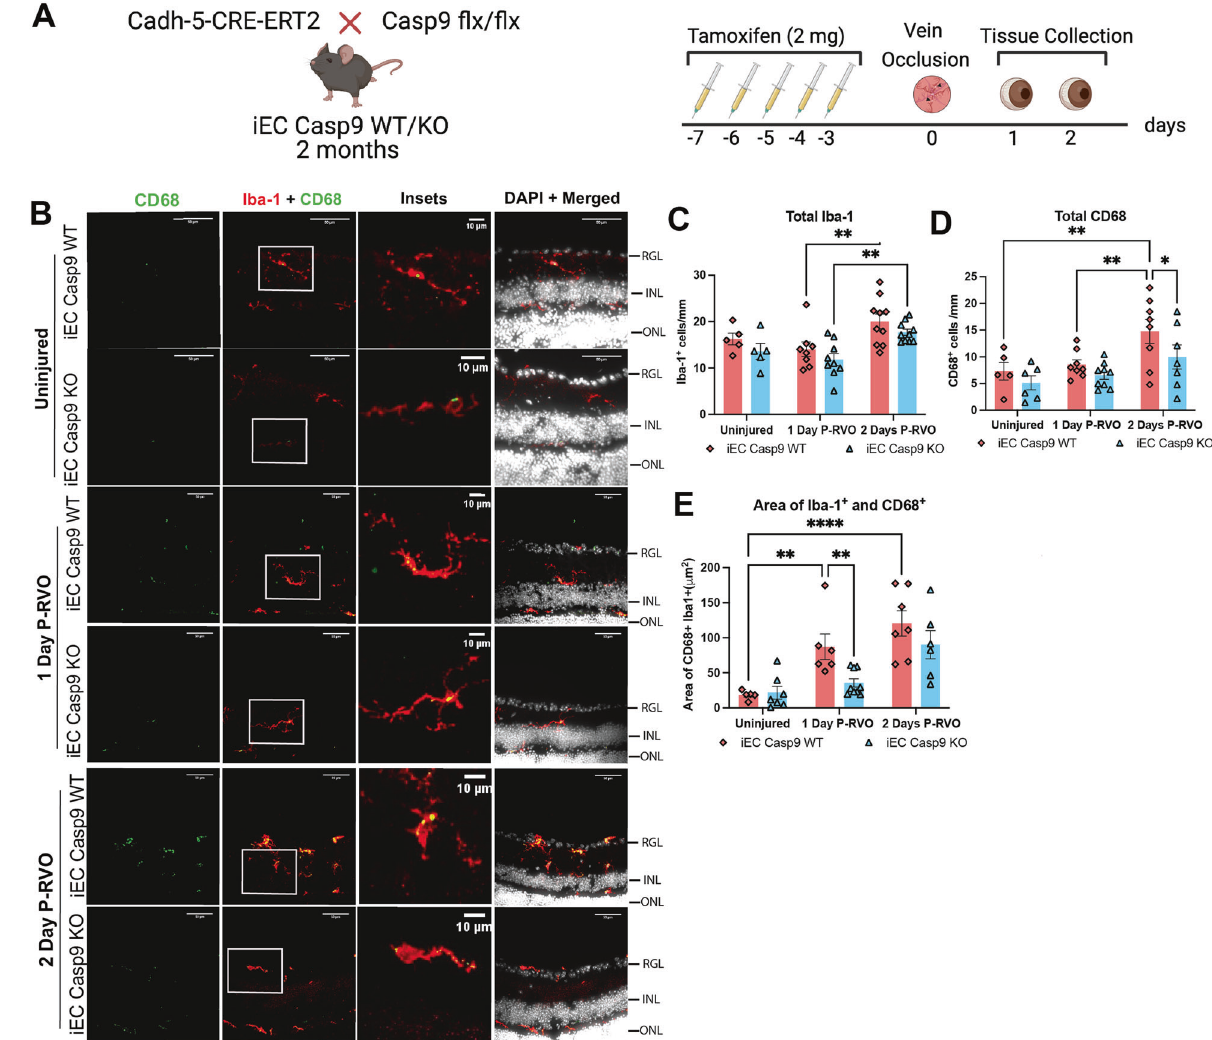
P-RVO. Created with BioRender.com. B Retinal cross-sections from uninjured, one and two days P-RVO iEC Casp9 WT and KO mice were stained with CD68 (green), Iba-1 (red), and DAPI (white). Scale bar 50 µm and inset 10 µm. C Quanti fi cation of the number of Iba-1 + cells in ( n = 8) and KO ( n = 9), and two days P-RVO iEC Casp9 WT ( n = 8) and KO ( n = 7). E Quanti fi cation of percent area of colocalization of Iba-1 + and CD68 + cells in uninjured iEC Casp9 WT ( n = 5) and KO ( n = 5), one day P-RVO iEC Casp9 WT ( n = 6) and KO ( n = 9), and two days P-RVO